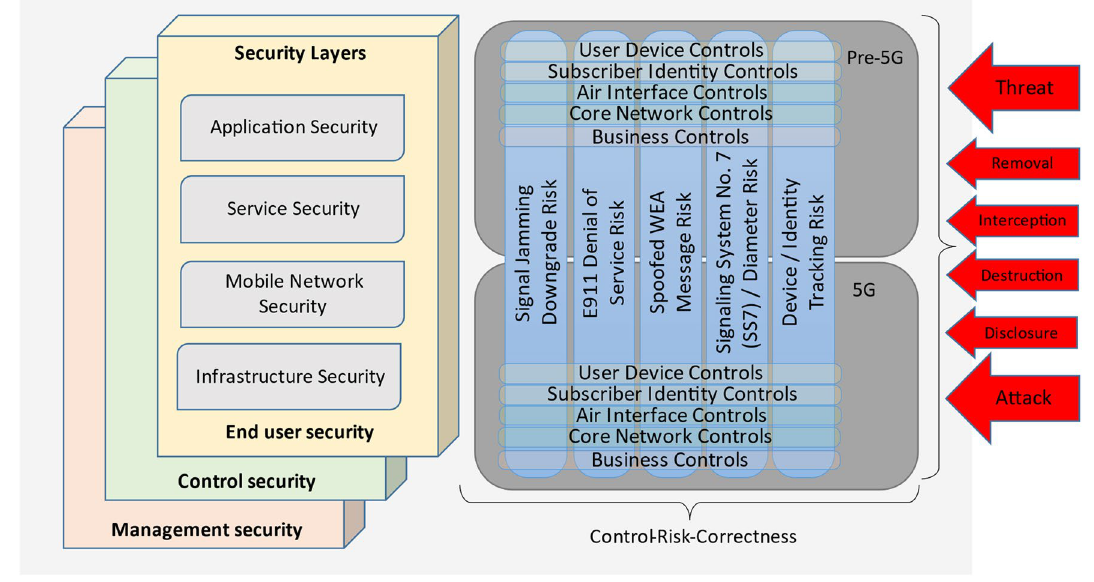
Fig. 3 Proposed control risk correctness architecture Table 6 User device